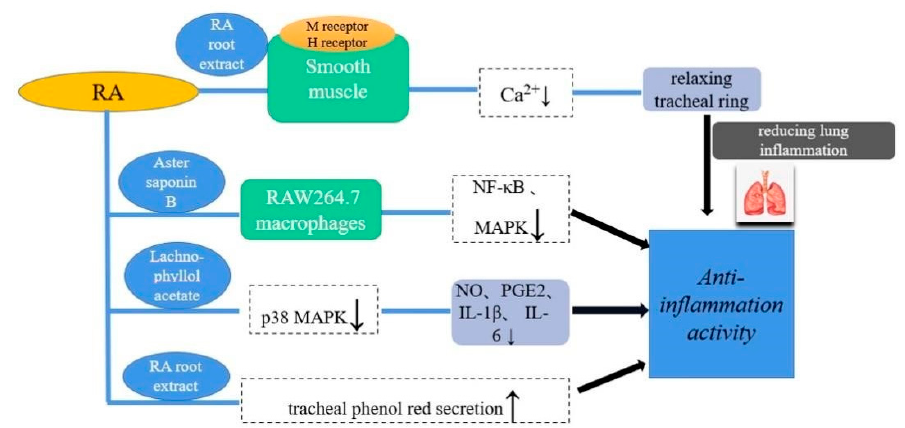
Figure 8. Anti-inflammatory mechanisms of Radix Asteris.